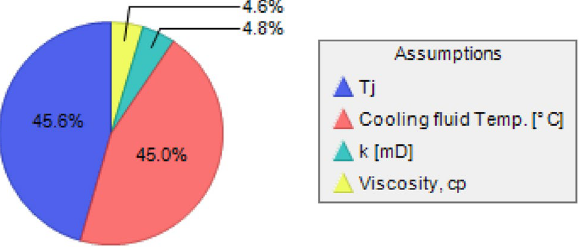
Fig. 3 Contribution of inputs (assumptions) on the variance of the calculated cooled area around the wellbore during stimulation fluid injection